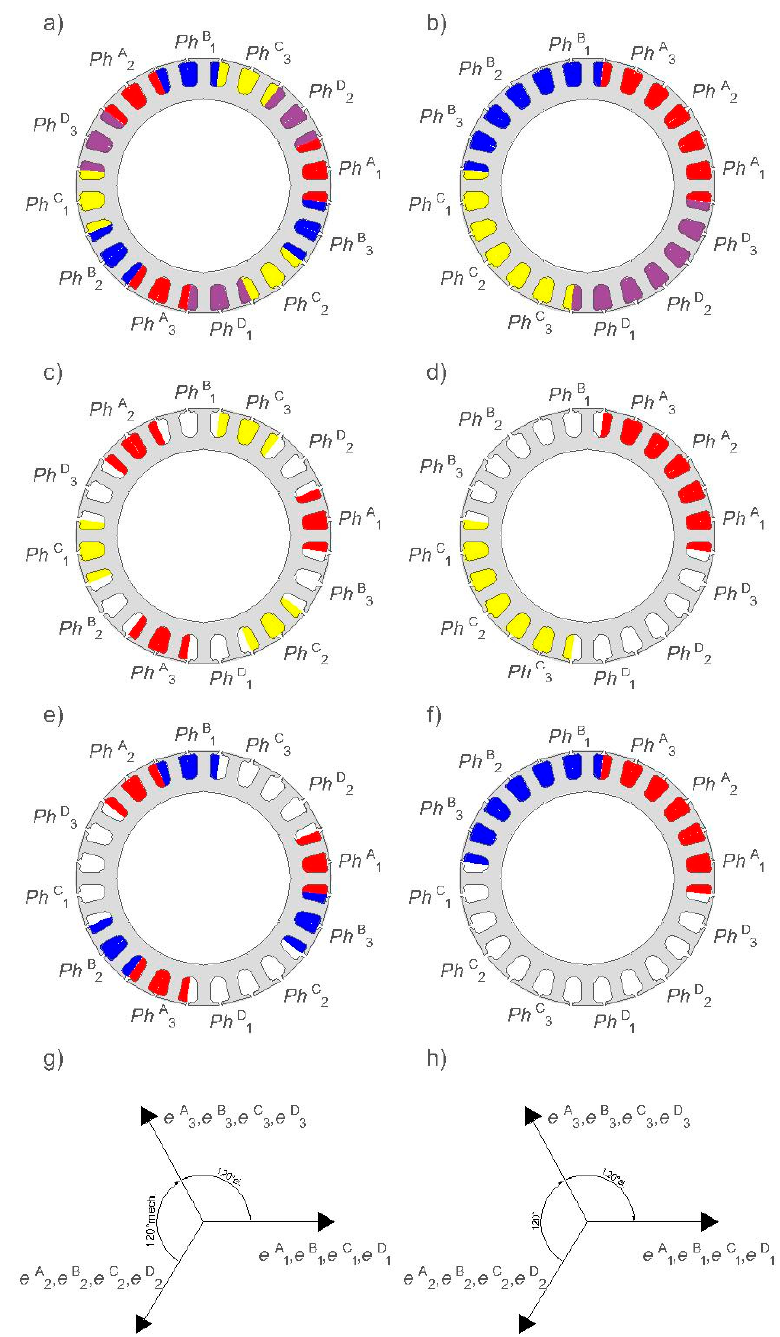
Table legend: QCO — quad-channel operation, TCO — triple-channel operation, DCO — dual- channel operation, SCO — single-channel operation.